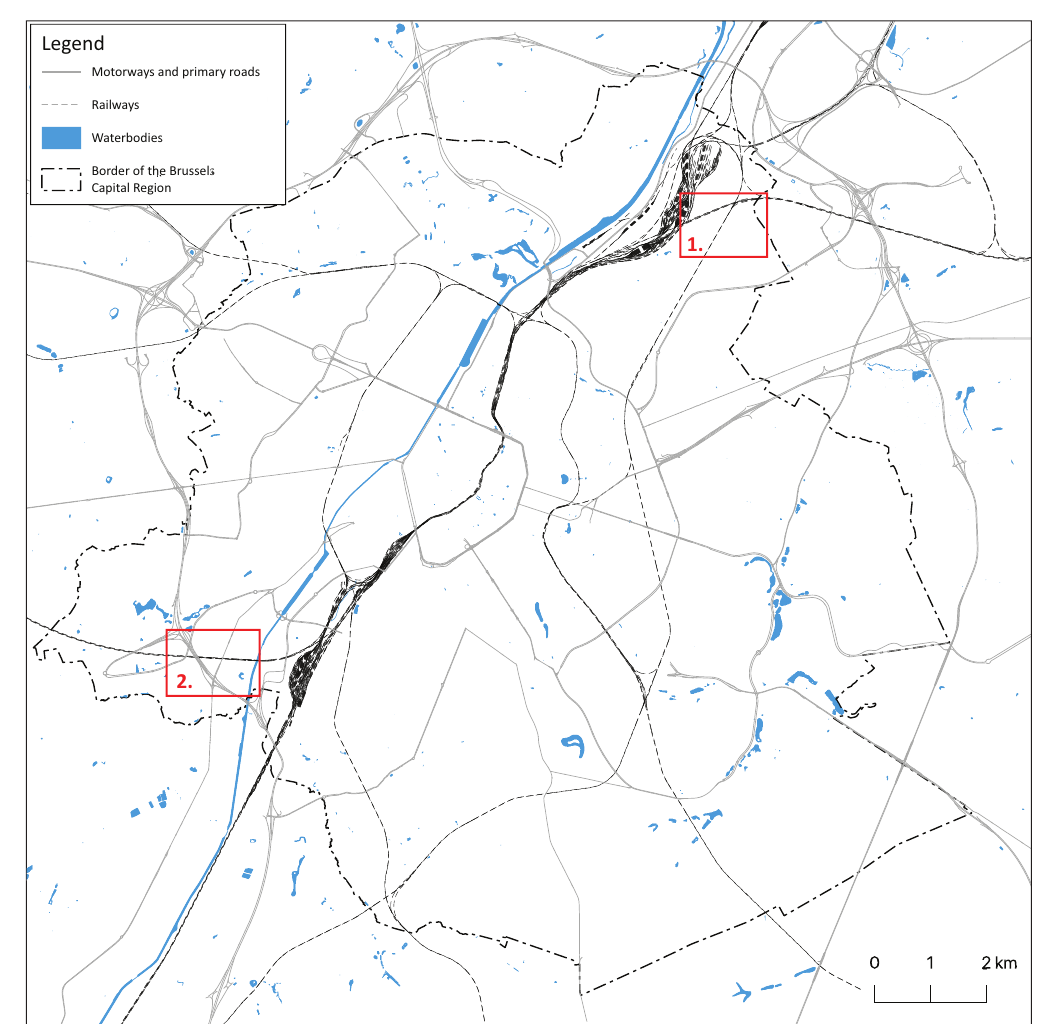
Figure 3. Map of the Brussels Capital Region. The NorthCity Haren project is located at no. 1 and the NovaCity and CityCampus projects are located at no. 2. The red rectangles correspond to the excerpts from the land‐use map and aerial photographs in Figure 4. Mapped by Michael Ryckewaert. Sources: UrbIS (2020) and OpenStreetMap